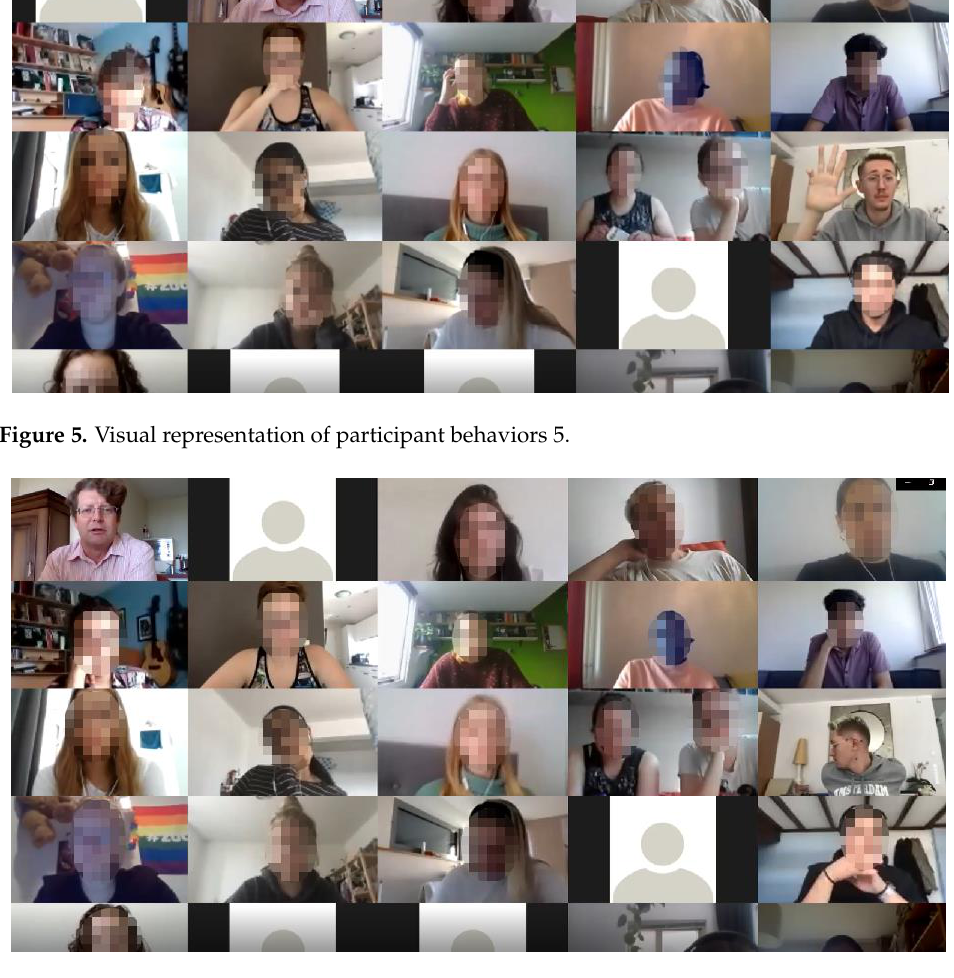
Figure 6. Visual representation of participant behaviors 6.